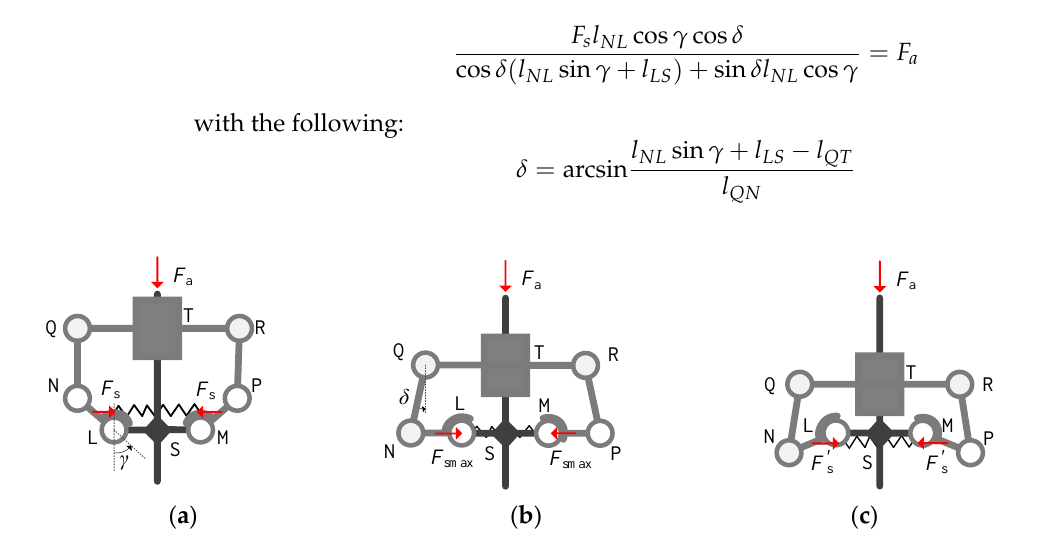
Figure 7. Schematic diagram of compliant bistable structure in different positions: ( a ) a static equilibrium position; ( b ) an unstable position; ( c ) another static equilibrium position.